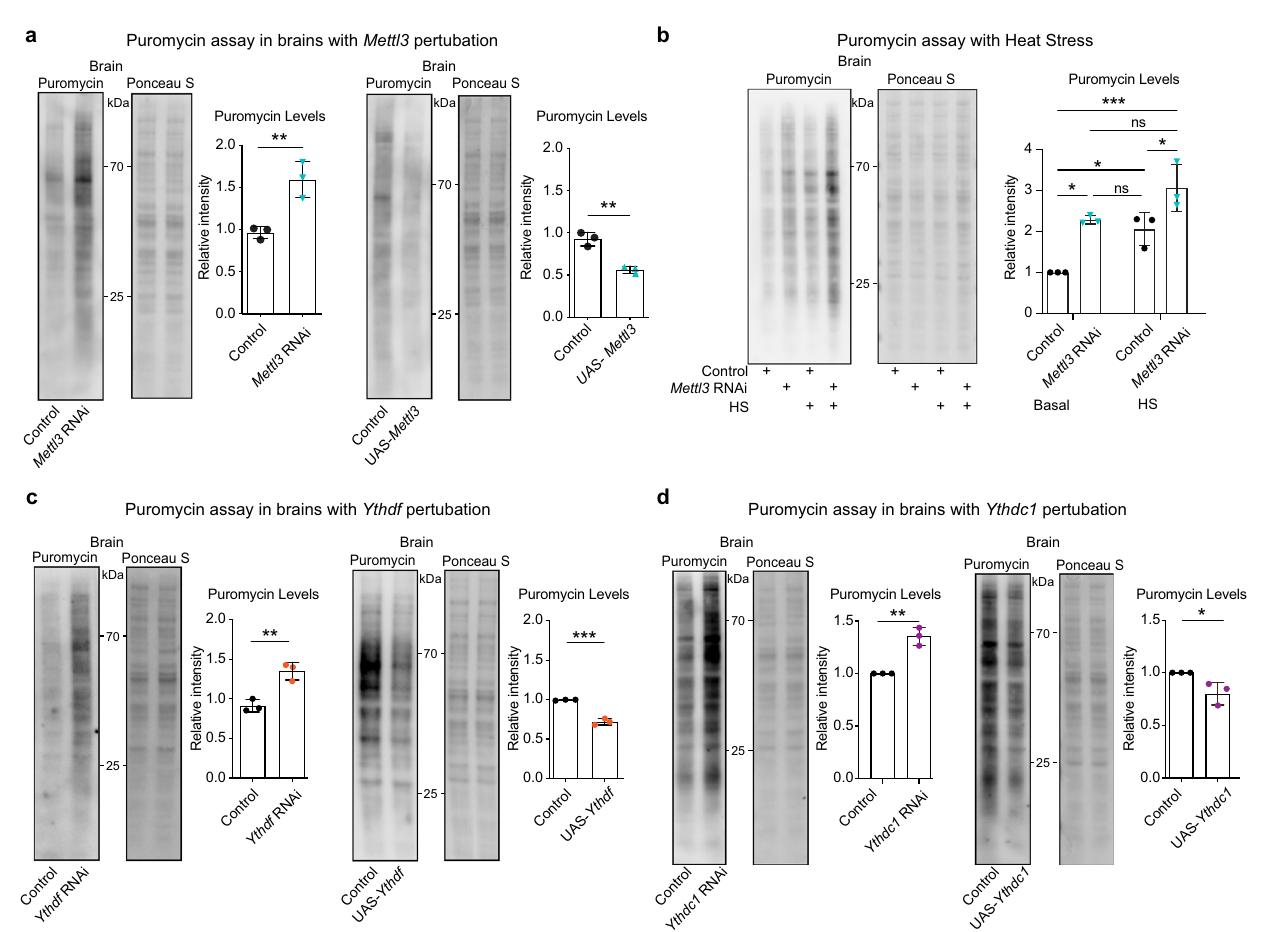
Fig.6| Mettl3 attenuatesproteintranslationinthebrain.a Control, Mettl3 RNAi, and UAS-Mettl3 upregulation fl ies were fed 600uM puromycin for 24h. (Genotypes: DaGal4 > mCherry RNAi vs DaGal4 > Mettl3 RNAi, ElavGS > UAS- mCherryvsElavGS> UAS-Mettl3) .Brainsweredissectedfromtheheads,andprotein immunoblotswereprobedforpuromycinincorporationineachsample.PonceauS staining shows total protein levels. n =3 biological replicates, 15 brains per repli- cate. Data presented as mean±SD, * p <0.05, ** p <0.01, Student ’ s two-tailed t -test. p =0.0085, p =0.0024. b Control and Mettl3 RNAi fl ies were HS for 30min and then fed 600uM puromycin for 4h or control and fed puromycin for 4h. (Genotypes: DaGal4 > mCherry RNAi vs DaGal4 > Mettl3 RNAi). Brains were dis- sected after 4h, and protein immunoblots were probed for puromycin levels in